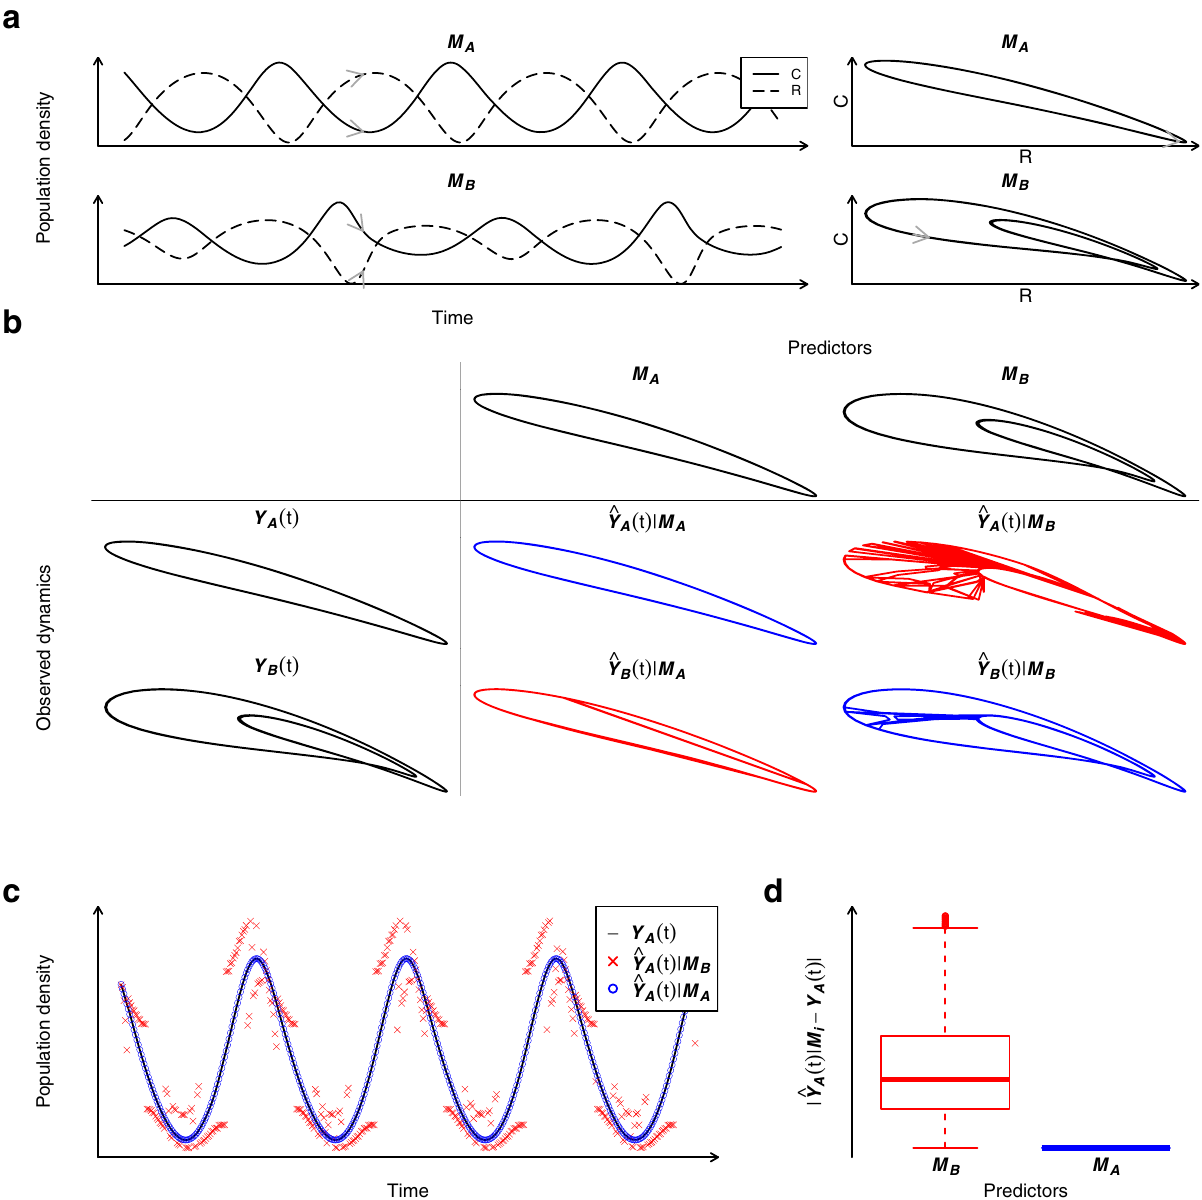
Fig. 1 An illustration of the methodological approach of detecting alternative attractors in ecosystem dynamics. a Time-series plot (left panels) and phase space plot (right panels) showing the dynamics of a consumer ( C ) and its resource ( R ) in a food-chain model. M A and M B are abbreviations for two dynamical regimes: a 2-point limit cycle and a 4-point limit cycle, respectively. The gray arrow illustrates the fl ow in phase space. b The observed dynamics of two different dynamical regimes ( Y A (t) & Y B (t)) is estimated using information from either of two dynamical regimes ( M A and M B ) giving rise to within ( ^ Y A ð t Þj M A and ^ Y B ð t Þj M B [in blue]) and across regime predictions ( ^ Y A ð t Þj M B and ^ Y B ð t Þj M A [in red]). c Within ( ^ Y A ð t Þj M A ) and across regime predictions ( ^ Y A ð t Þj M B ) for one species in one dynamical regime ( Y A (t)). d Absolute predictions errors for across and within regime predictions are used to test if the temporal dynamics within two contrasting regimes are dissimilar. Predator dynamics is here used to predict consumer and resource dynamics (See “ Methods ”